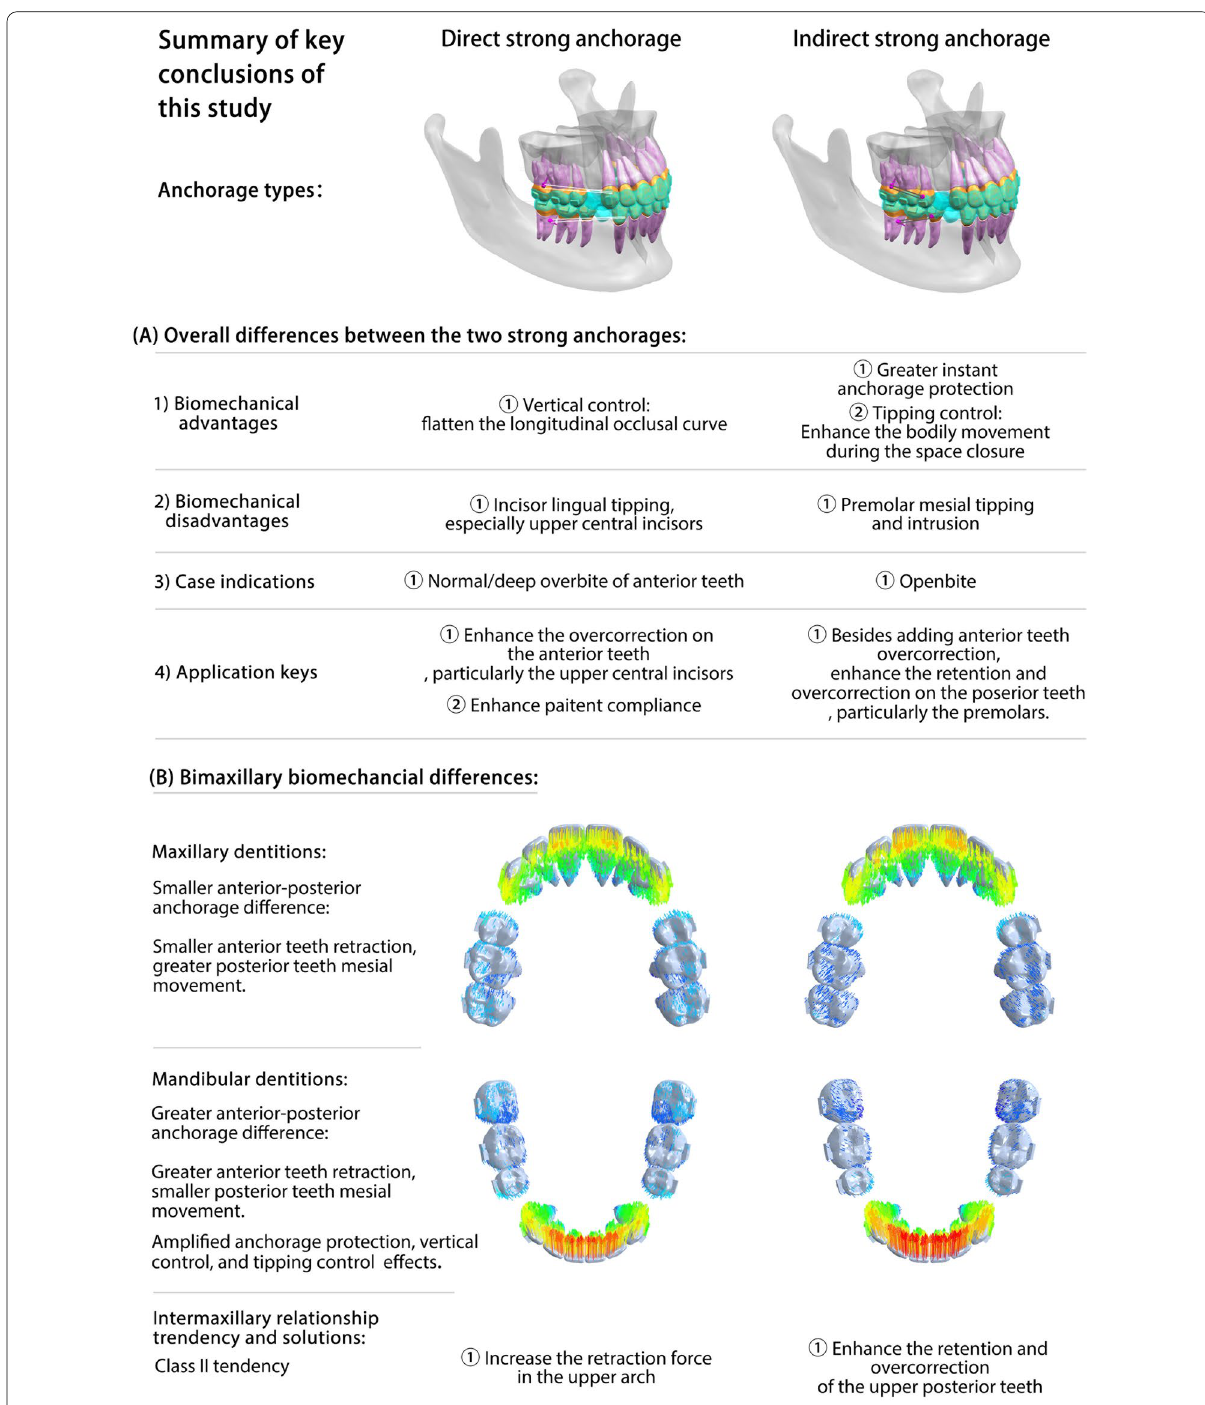
Fig. 7 Biomechanical effects of CAs on bimaxillary space closure under two strong anchorages. A Overall differences in biomechanical effects between the two strong anchorages. B Different biomechanical effects of CAs on bimaxillary space closure under two strong